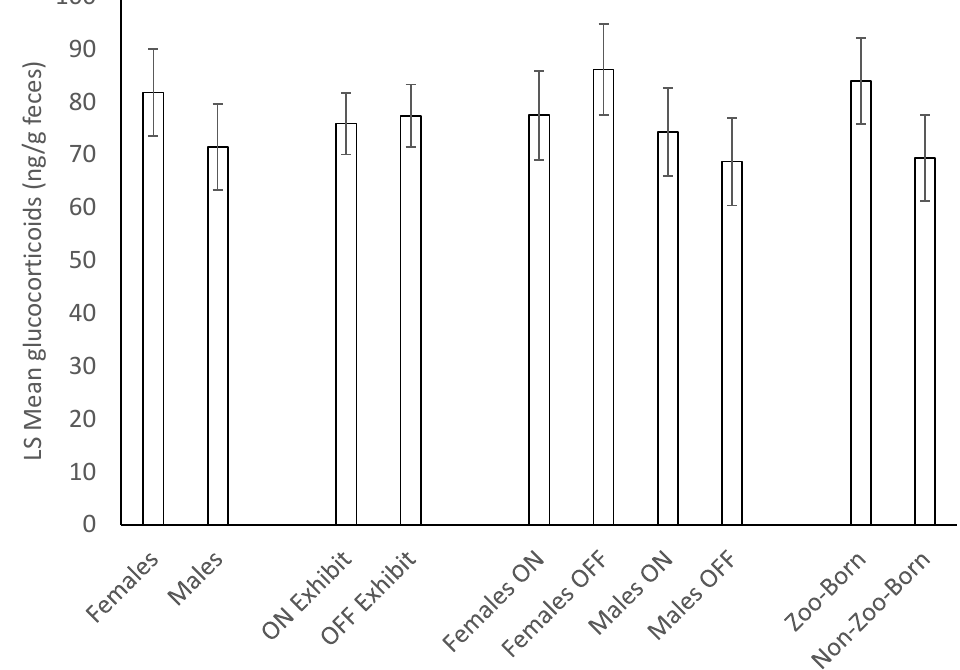
Figure 2. Mean ± SEM fecal glucocorticoid concentrations (N gpigs = 16, N samples = 344) in guinea pigs in relation to sex, birth origin, and housing location. There are no significant effects of sex, location, birth origin, or an interaction between sex and location.